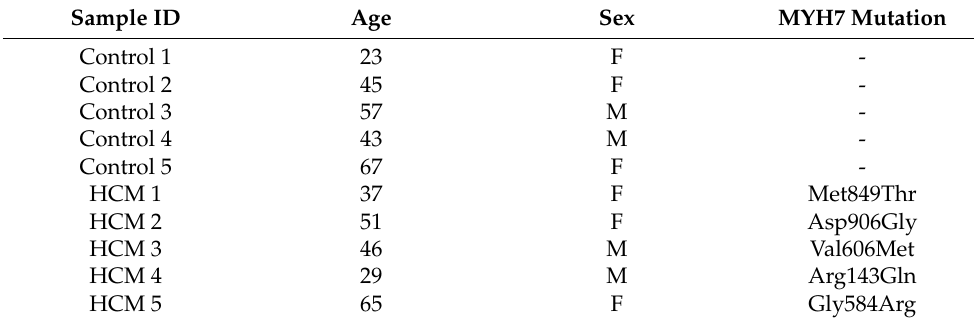
Table 1. Patient